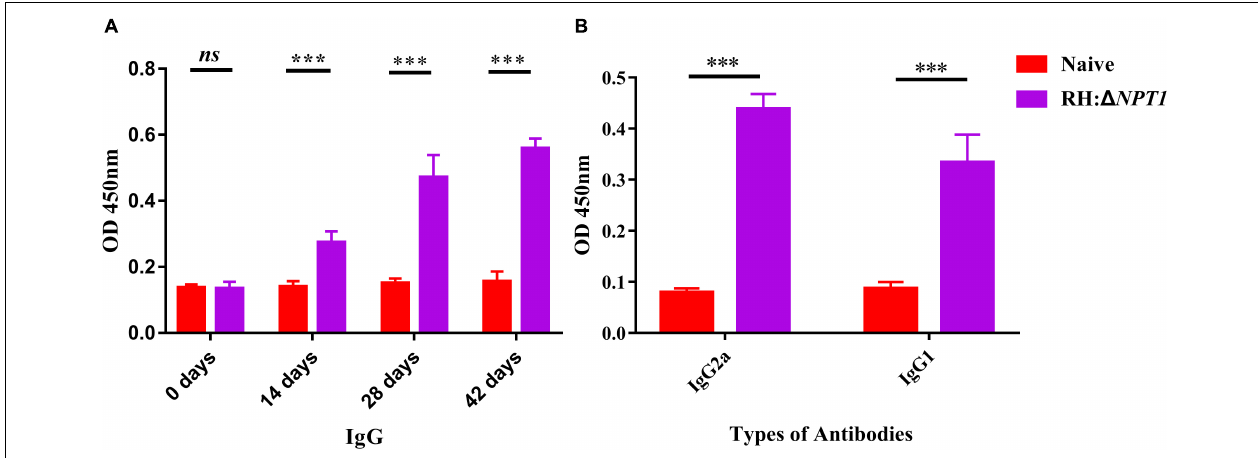
FIGURE 3 | The level of humoral response in the serum of mice immunized with RH: (cid:49) NPT1 . (A) Levels of IgG antibody in the sera obtained from RH: (cid:49) NPT1 -immunized and non-immunized mice at 0, 14, 28, and 42 days post-vaccination suggest an effective humoral response was elected by the vaccination. (B) Levels of IgG subclass (IgG2a and IgG1) antibodies in the sera were collected at 42 days post-immunization, indicating a Th1 response was induced. The average of six biological replicates and three technical replicates are shown. The results are presented as the mean of OD450 ± SD ( n = 6; ∗∗∗ P < 0.001; n.s. , not significant;